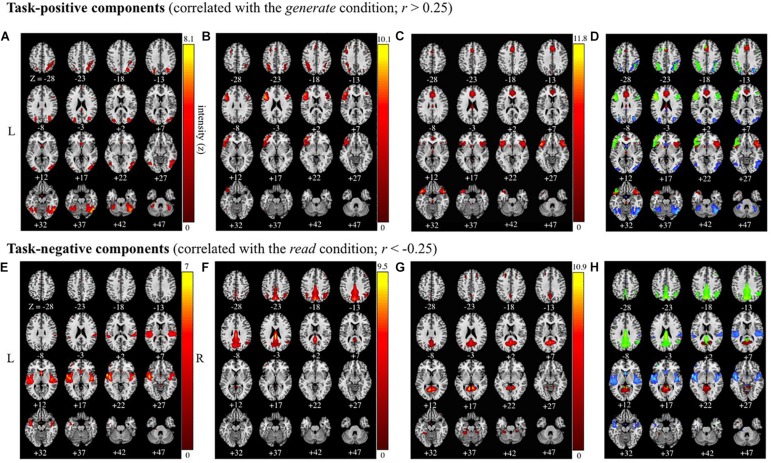
Task-positive and task-negative components (correlated with the generate and read conditions |r| > 0.25). Images are presented in neurological orientation (R = R). Group average independent components positively correlated (r > 0.25), (A–C), and negatively correlated (r < –0.25), (E–G) with the task time course, along with composite images for task-positive (D) and task-negative (H) components presented below. Components span the following brain regions: (A) bilateral occipital; (B) bilateral (left-lateralized) inferior frontal gyrus and precentral gyrus; (C) anterior insula and superior temporal gyrus; (D) composite image of task-positive components (A–C); (E) bilateral superior temporal gyrus; (F) bilateral precuneus and posterior cingulate cortex; (G) posterior cingulate cortex and culmen; (H) composite image of task-negative components (E–G).